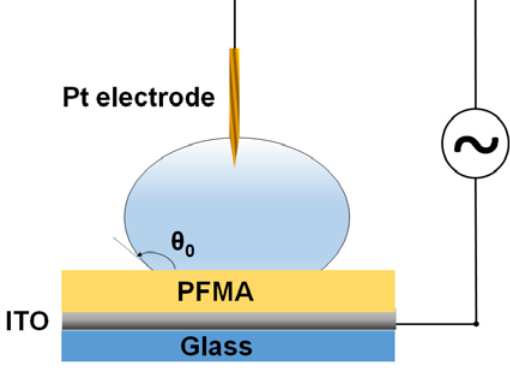
Scheme 2. Schematic diagram of electrowetting test.